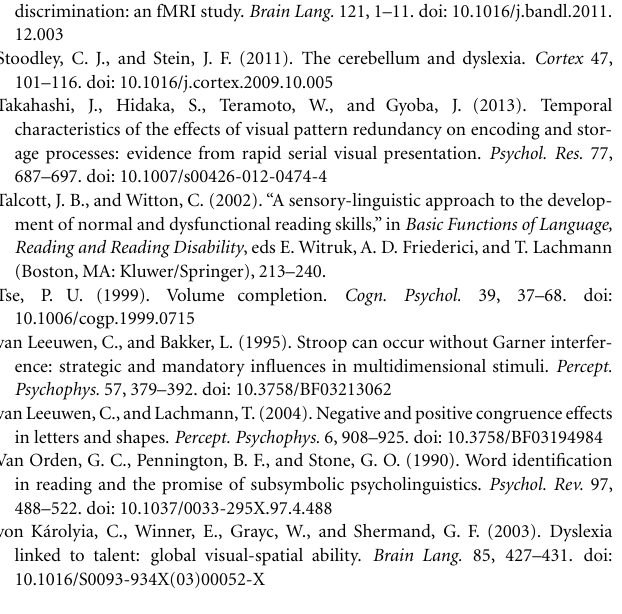
grouping and figure–ground organization . Psychol. Bull. 138, 1218–1252. doi: